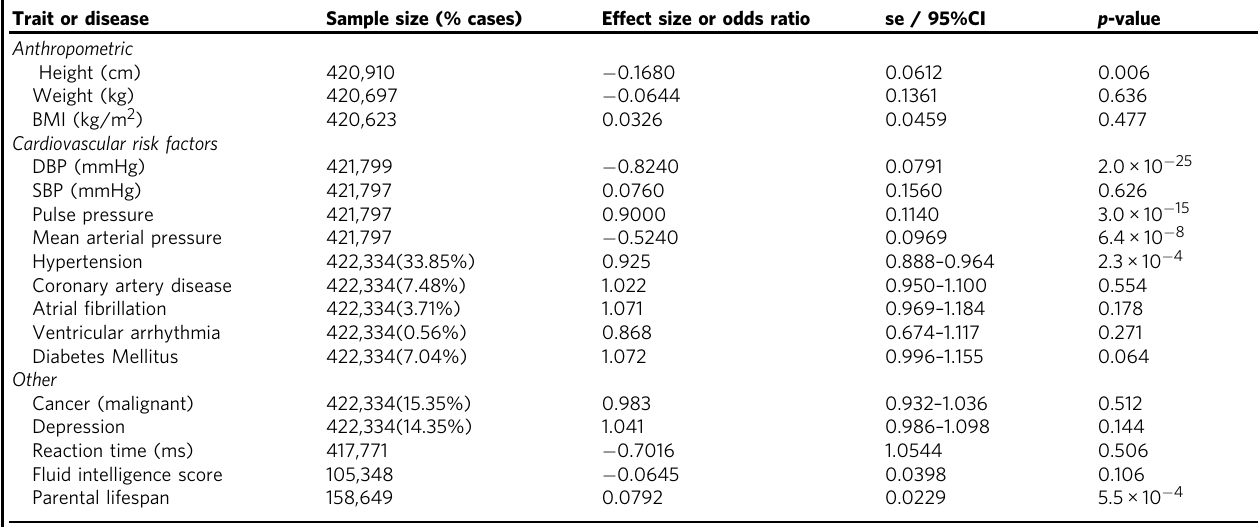
Table 2 Association with clinical characteristics Trait or disease Sample size (% cases) Effect size or odds ratio Anthropometric